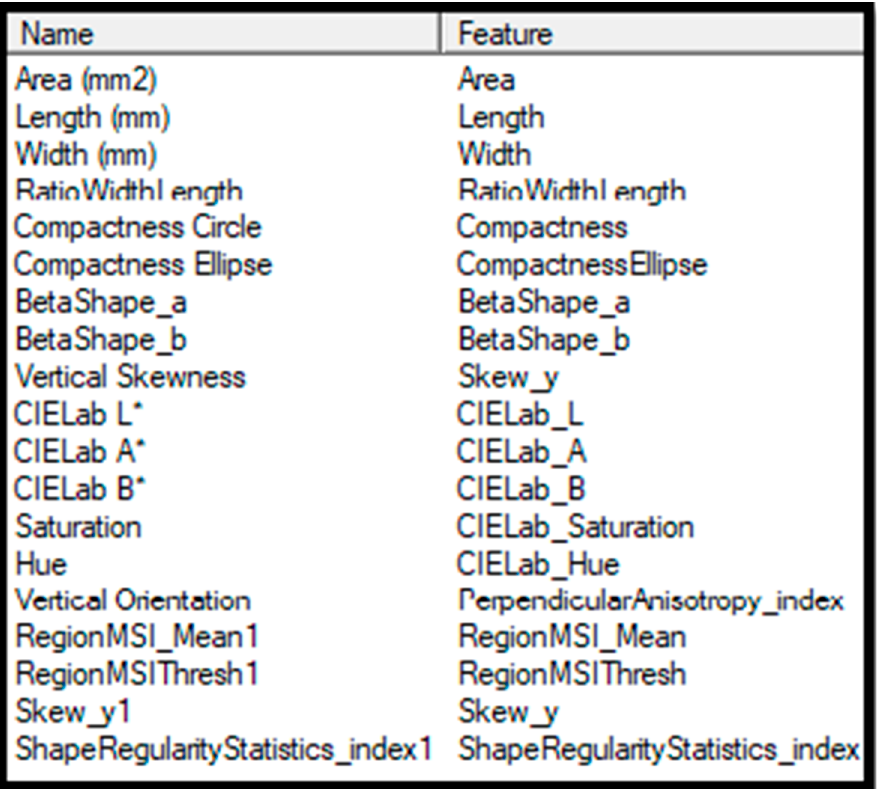
Figure 2. List of the 19 extracted variables from multi spectral images.